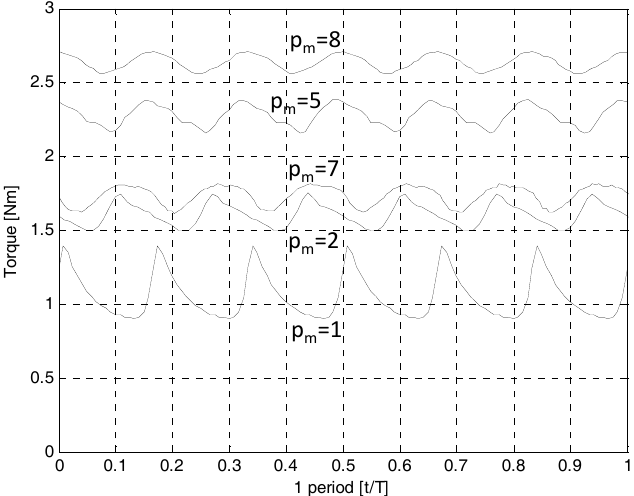
Figure 8. Torque characteristics of vernier motors (with 2A phase current).